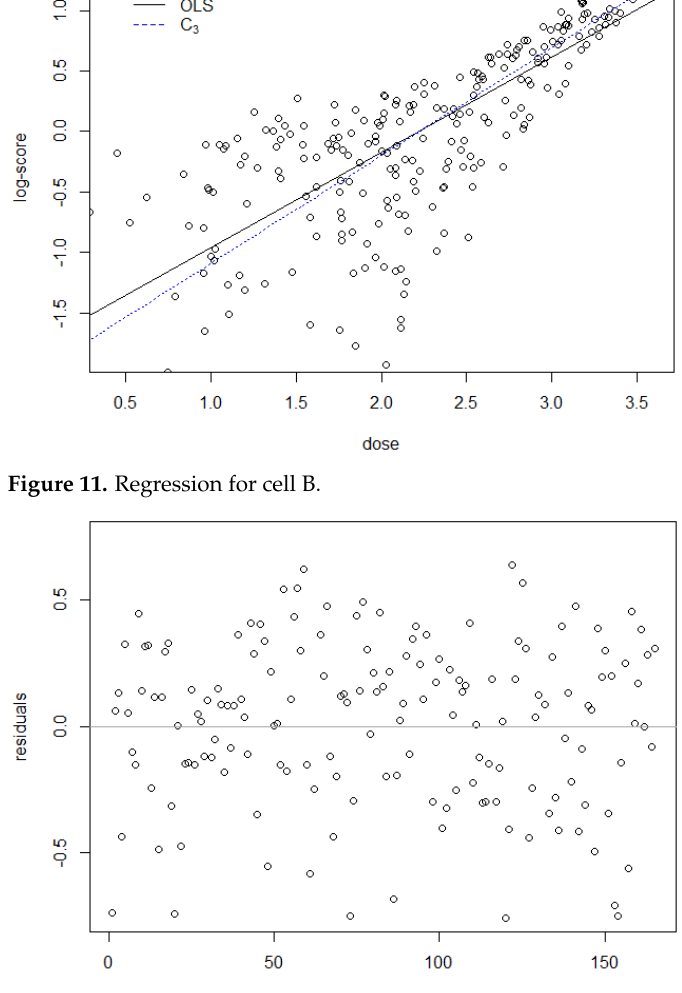
Figure 12. OLS regression residual plot for cell A.